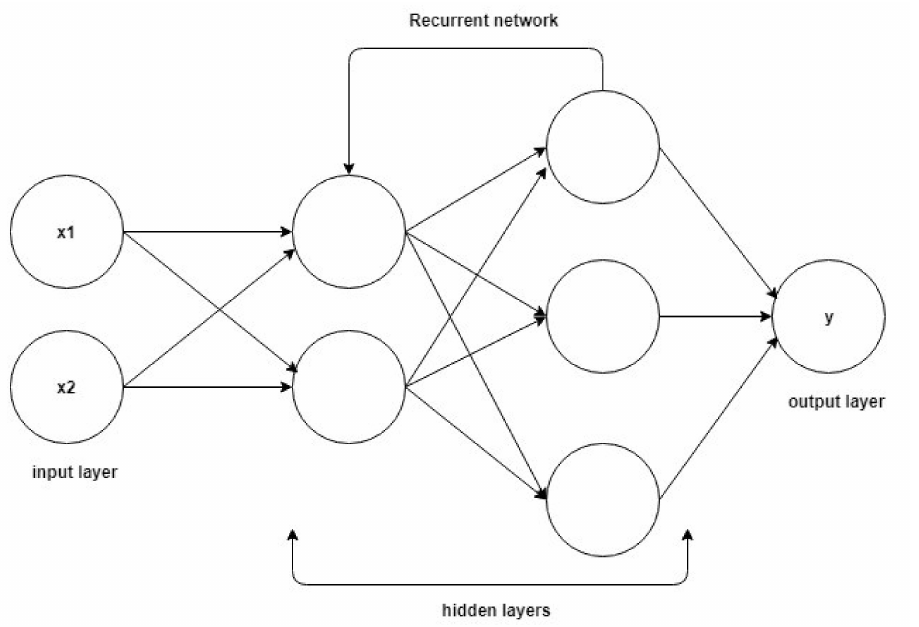
Figure 5. LSTM-based deep neural